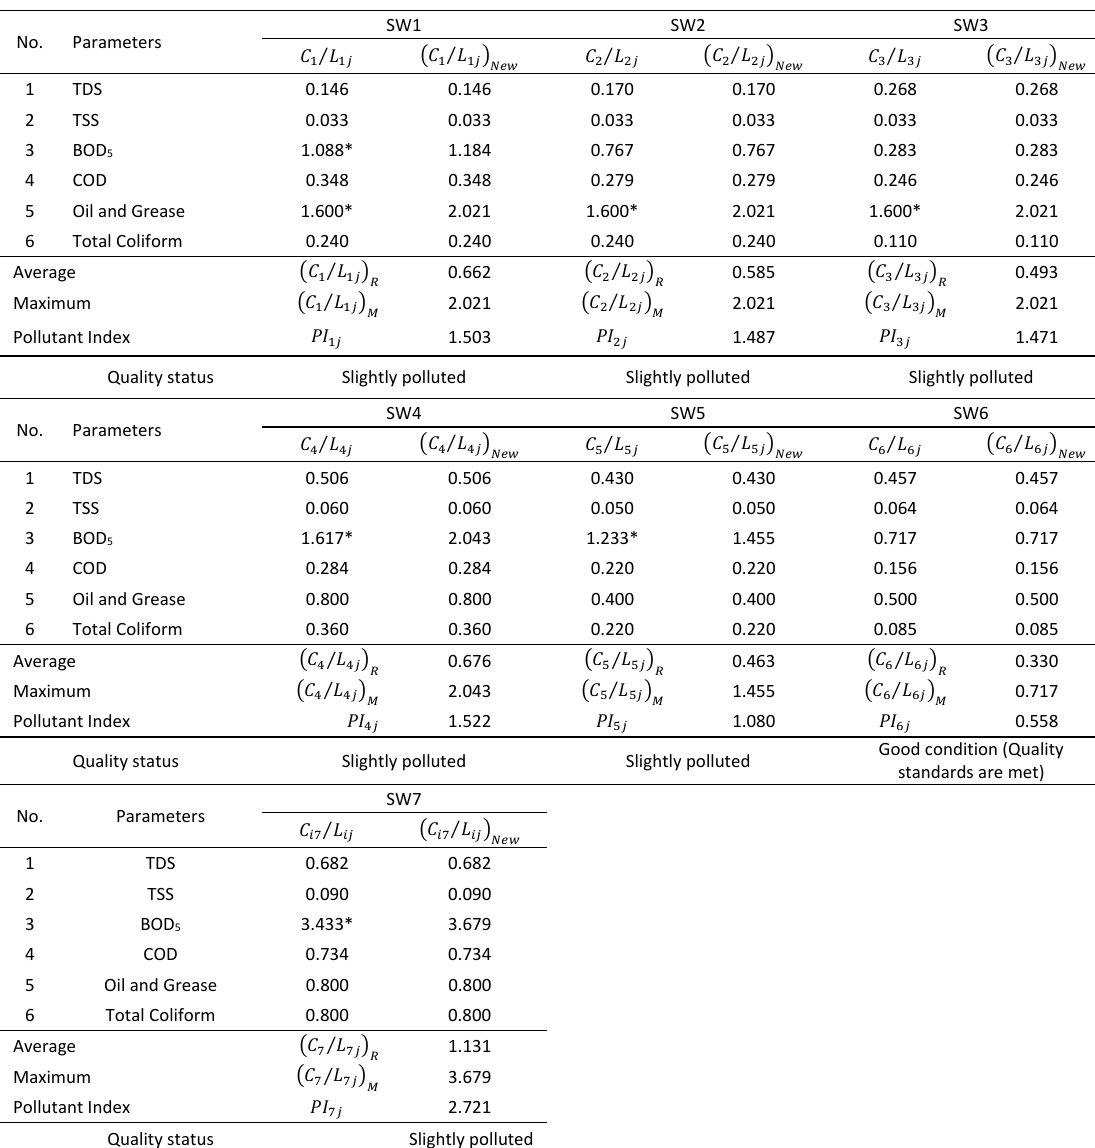
Table 6: Pollution Index values and water quality status at seven points along the Cangkring River segment near the oil and gas production